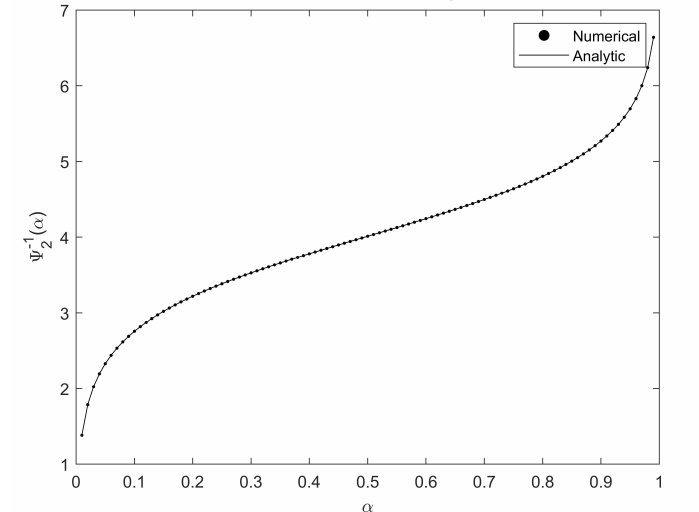
Figure 1. Numerical and analytic solutions of inverse uncertainty distribution of X T .